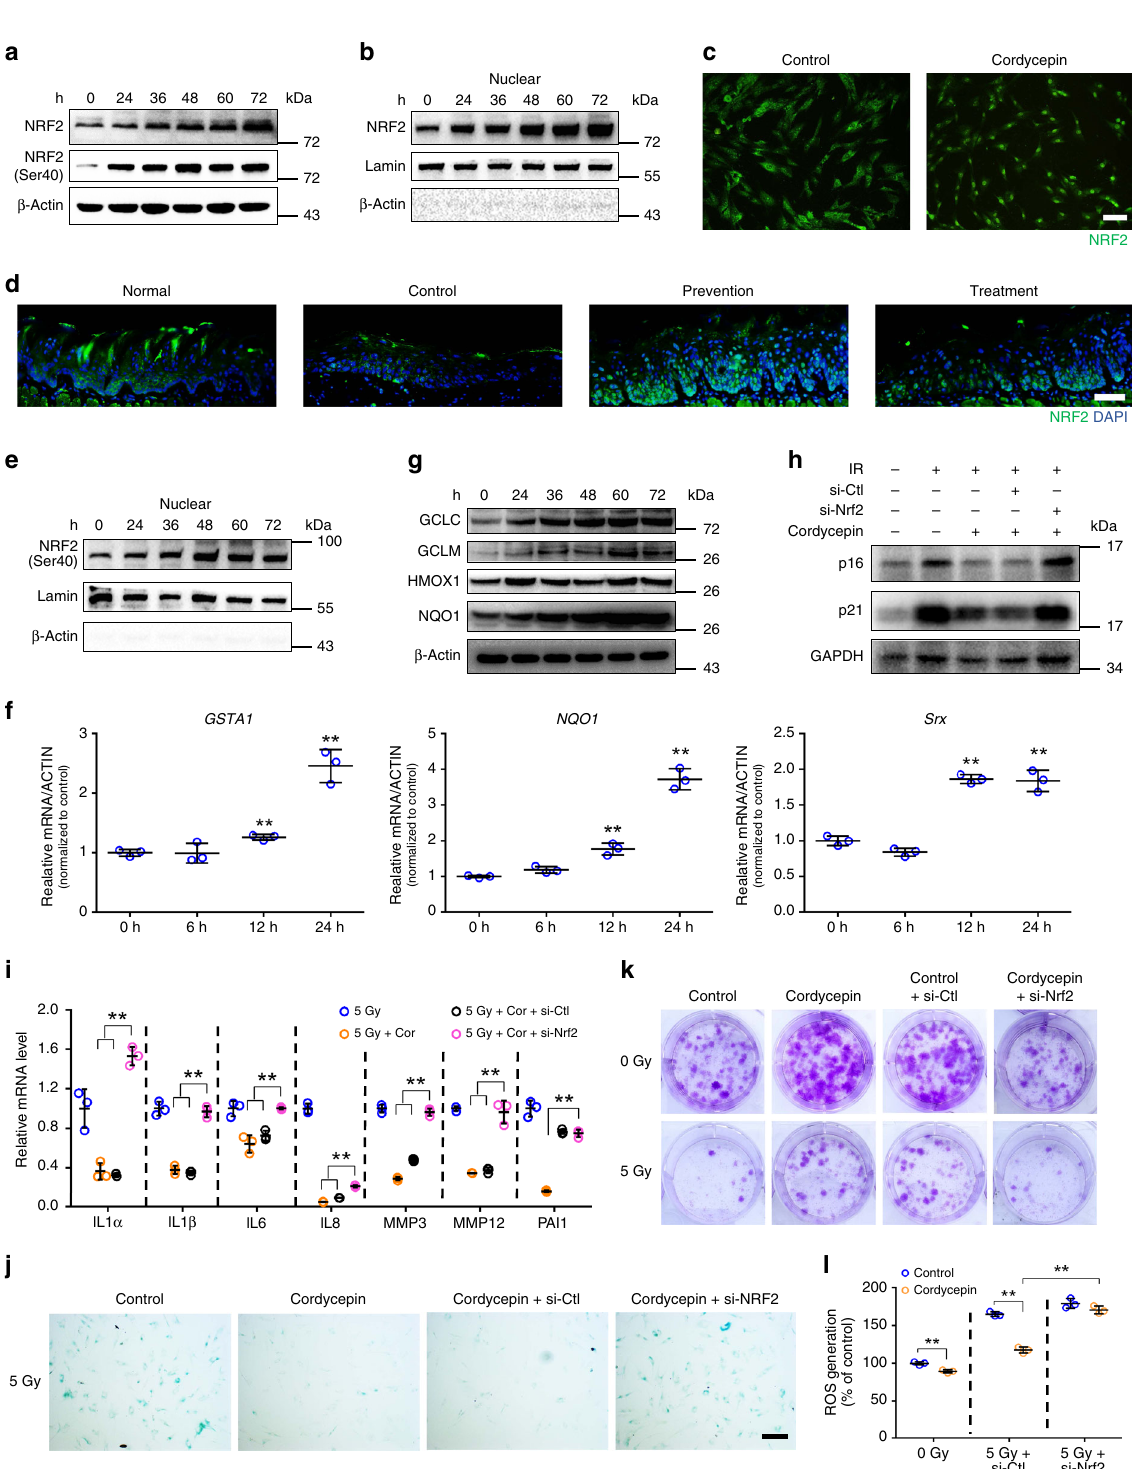
(Fig. 7f and Supplementary Fig. 9c) and 3-methyladenine (3MA) (Fig. 7g and Supplementary Fig. 9d), suggesting that the downregulation of Keap1 by cordycepin is likely mediated via autophagic degradation. To determine whether cordycepin stimulates autophagy, we examined the lipidation of LC3, a characteristic of autophagy that converts the LC3-I isoform to the electrophoretically more mobile LC3-II isoform and